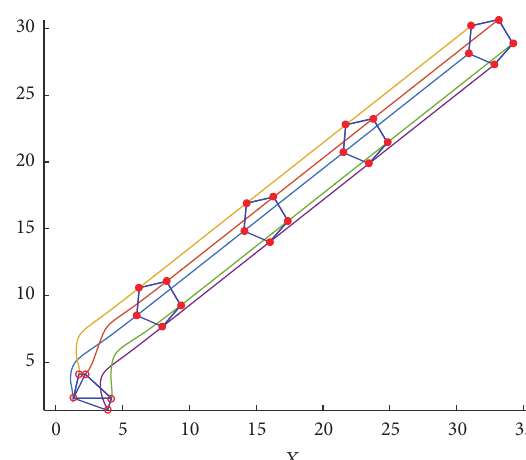
Figure 4: Multiagent flocking trajectories without obstacle.